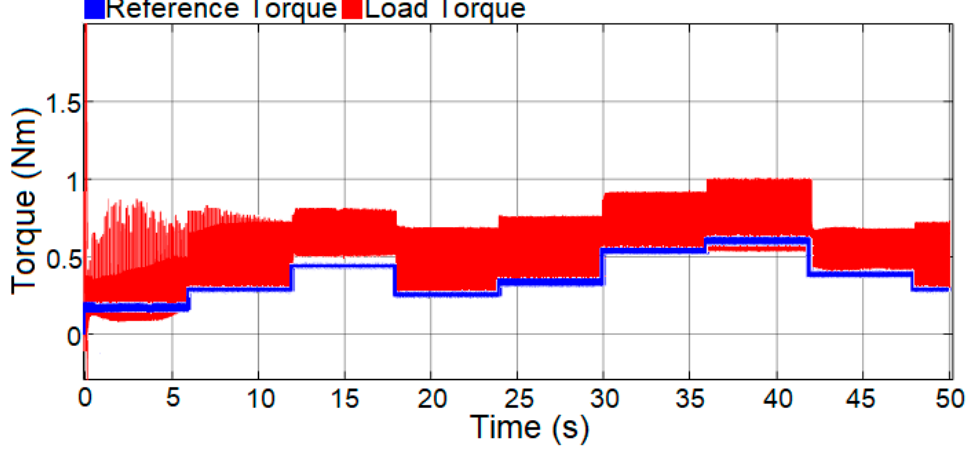
Figure 20. Reference and load torque (results from simulation).